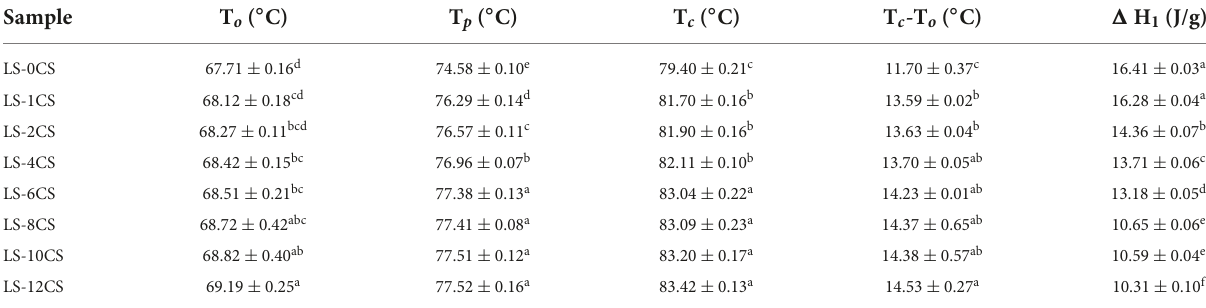
TABLE 2 Thermal stability levels of lotus seed cross-linked resistant starch samples.